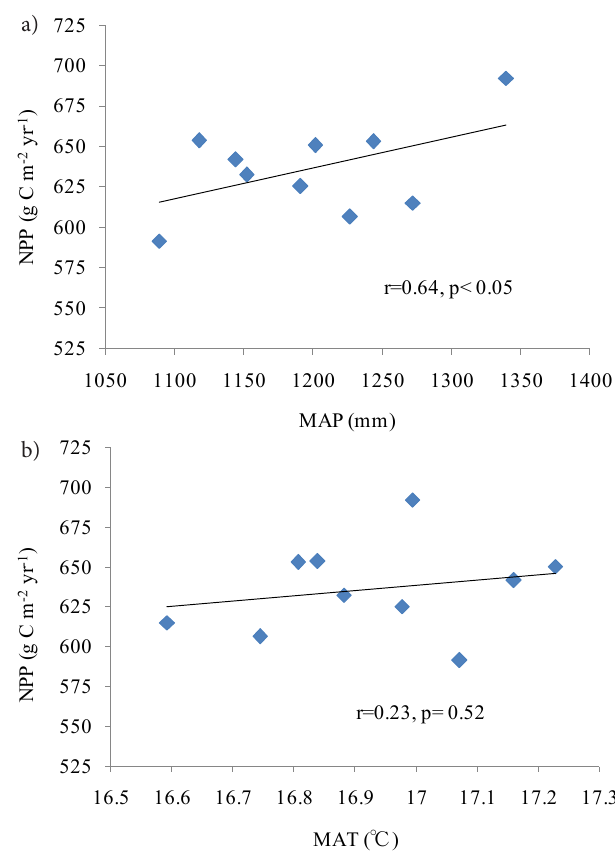
Figure 8. Correlation between net primary production of Chinese fir and climate variables from 2000–2010 on a regional scale. (a) Mean annual precipitation (MAP); (b) mean annual temperature (MAT). They both show linear trends. NPP of Chinese fir is significantly correlated to MAP but not to